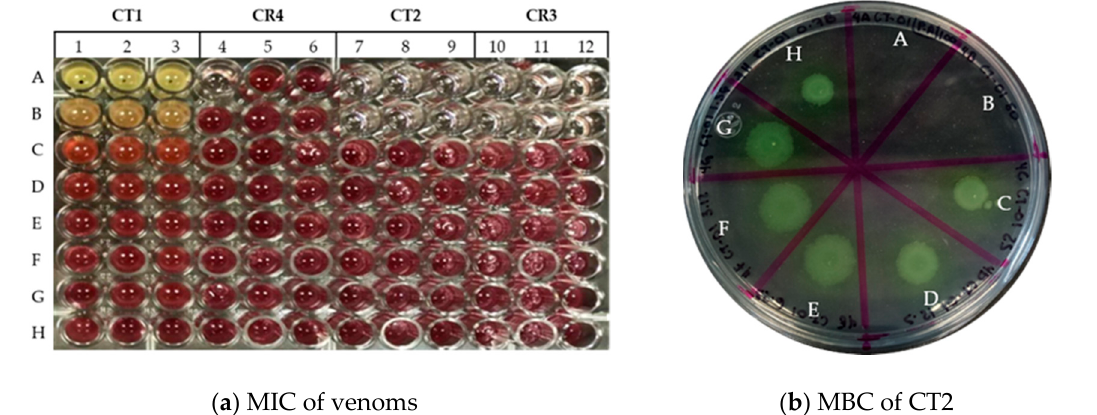
Figure 2. Antibacterial activity of rattlesnake’s venoms against P. aeruginosa : ( a ) columns 1–3, CT1 from 100 at 0.78 µ g / mL, columns 4–6, CR4 from 100 at 0.78 µ g / mL, columns 7–9, CT2 from 100 at 0.78 µ g / mL, columns 10–12, CR3 from 100 at 0.78 µ g / mL. The MIC value is read at the minimal concentration in which the color changes to pink; ( b ) Plate with P. aeruginosa + CT2 in Müller–Hinton agar; A CT2 to 100 µ g / mL, B CT2 to 50 µ g / mL, C CT2 to 25 µ g / mL, D CT2 to 12.5 µ g / mL, E CT2 to 6.25 µ g / mL, F CT2 to 12.5 µ g / mL, G CT2 to 6.25 µ g / mL, H CT2 to 0.78 µ g / mL. The MBC is read to the lowest concentration where no visible growth of the